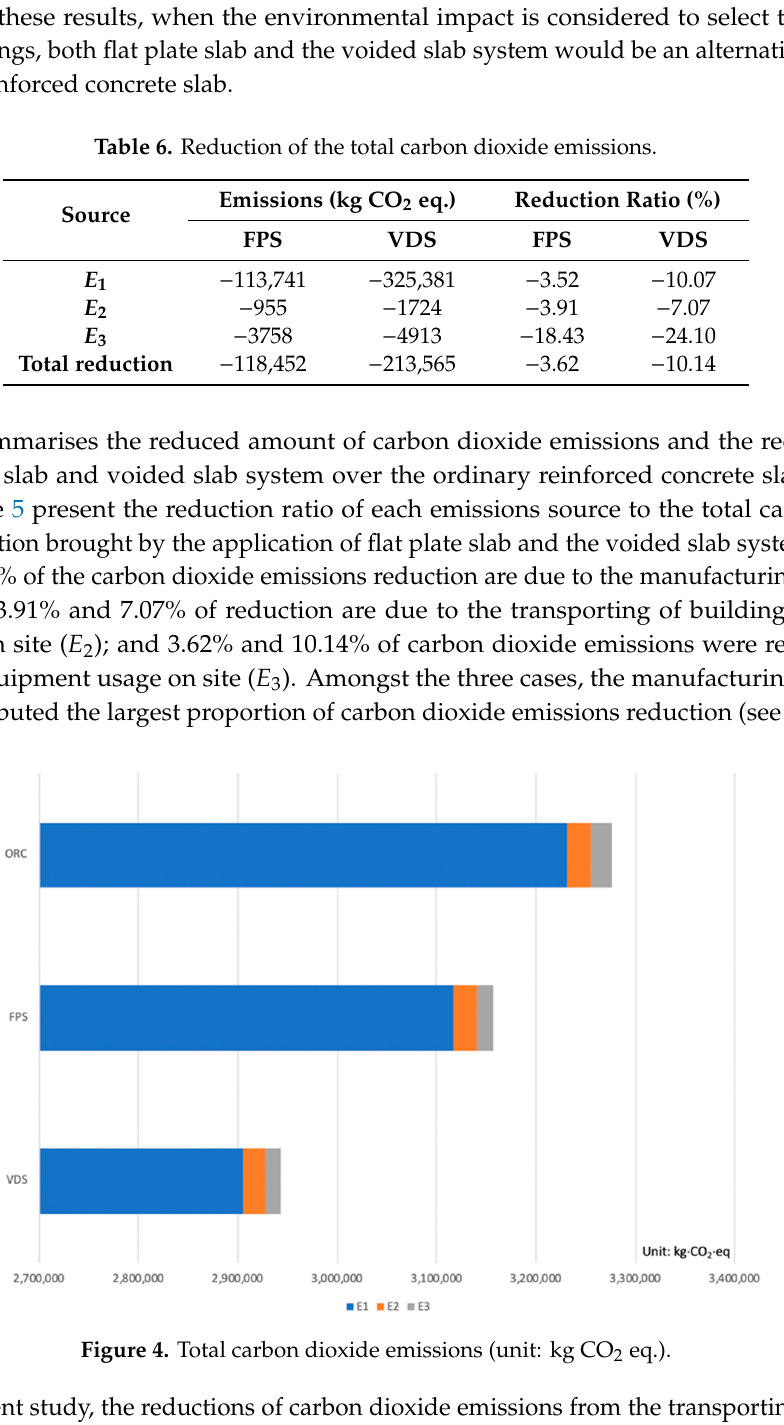
Table 6. Reduction of the total carbon dioxide emissions.